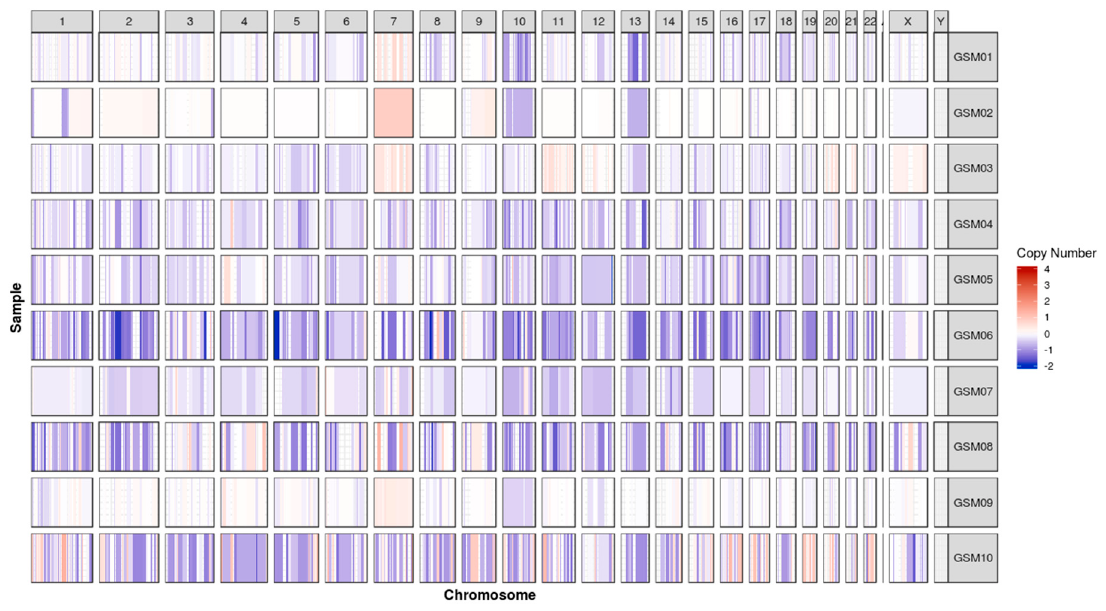
Figure 2. CNV plot for 10 gliosarcoma tumors. Scale is a log-ratio of a tumor versus paired normal (blood) sample across chromosomal locations ( X -axis).